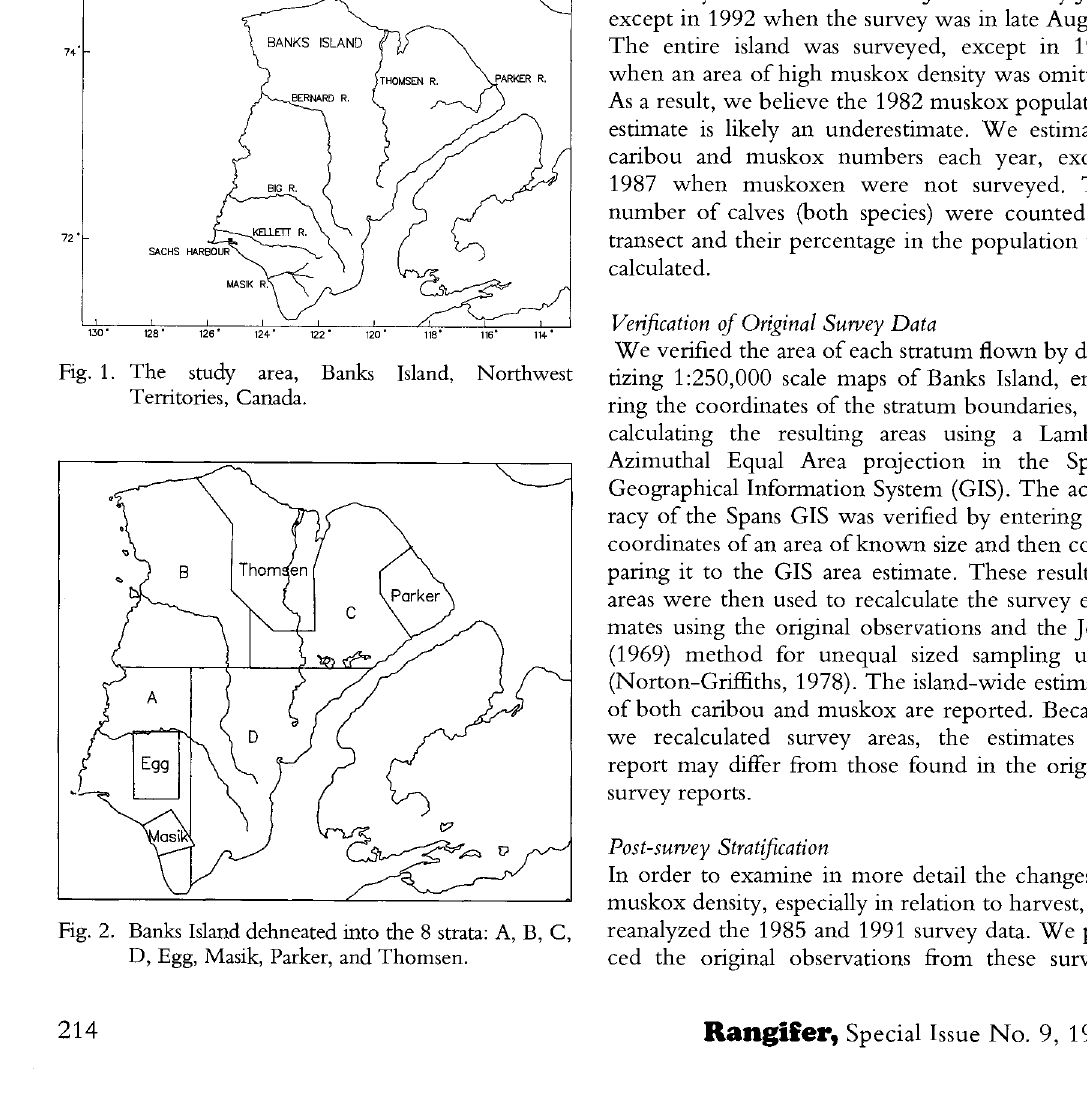
Fig. 2. Banks Island dehneated into the 8 strata: A, B, C, D, Egg, Masik, Parker, and